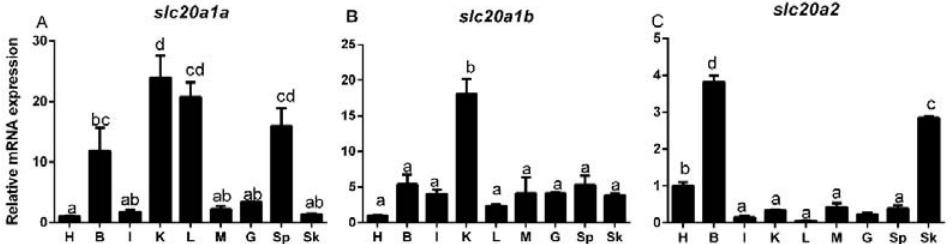
Figure 1. Quantitative PCR (Q-PCR) analysis for expression of slc20a1a ( A ), slc20a1b ( B ) and slc20a2 ( C ), across heart (H), brain (B), intestine (I), kidney (K), liver (L), muscle (M), gill (G), spleen (Sp) and skin (Sk) of grass carp. Data (mean ± SEM, n = 3 replicate tanks. For each tank, three fish were sampled for analysis) were expressed relative to expression of housekeeping gene ( gapdh and 18srRNA ). Expression of slc20s in heart was regarded as the relative expression 1. Data were subjected to one-way ANOVA and Tukey’s multiple range test. Bars that do not share a common letter mean significant di ff erence among di ff erent tissues ( p < 0.05).